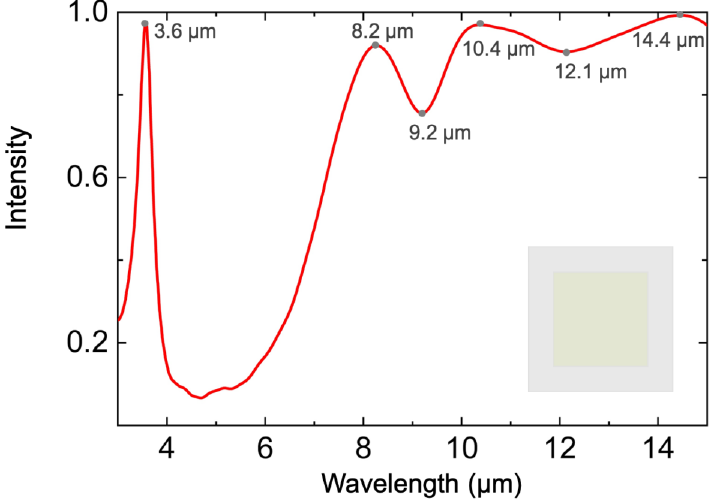
Figure 3. Simulated emission/absorption spectrum of the designed metasurface S3. The inset is the vertical view of the metasurface structure.